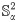
Fig a): The distribution of peptide plane O atom coordinates (ϑ, ψ) in our PDB pool of structures on the surface of the Frenet sphere Sα2. Fig b): The distribution of Cβ atom coordinates (θ, ϕ) in our PDB pool of structures on the surface of the Frenet sphere Sα2. In both Figures we have identified the α-helices (α), β-strands (β), left-handed α-helices (αL) and cis-peptide planes (cis).